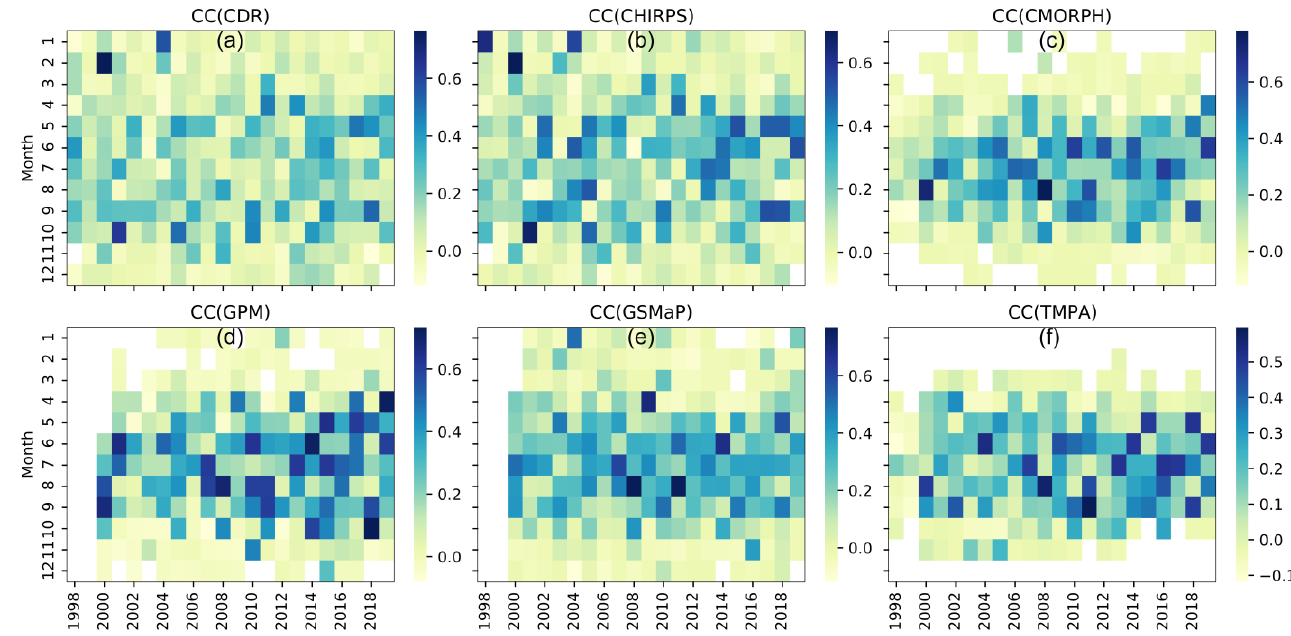
Figure 9. Annual correlation coefficient changes in different months of each dataset based on NW station daily data. ( a ) CDR, ( b ) CHIRPS, ( c ) CMORPH, ( d ) GPM, ( e ) GSMaP, ( f ) TMPA.